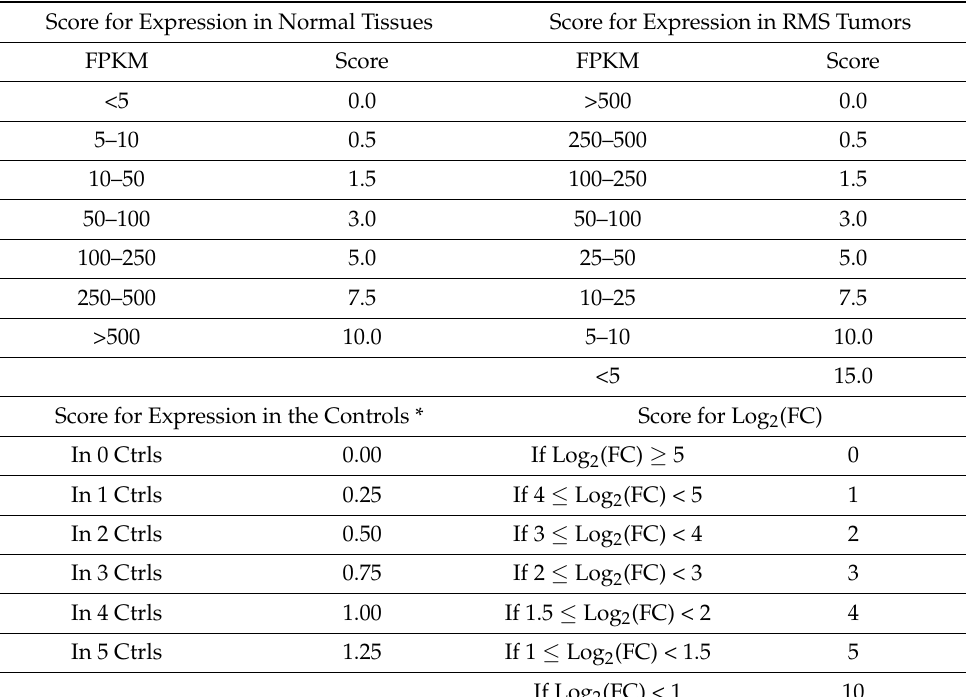
Table 2. Scoring strategy for mRNA expression.